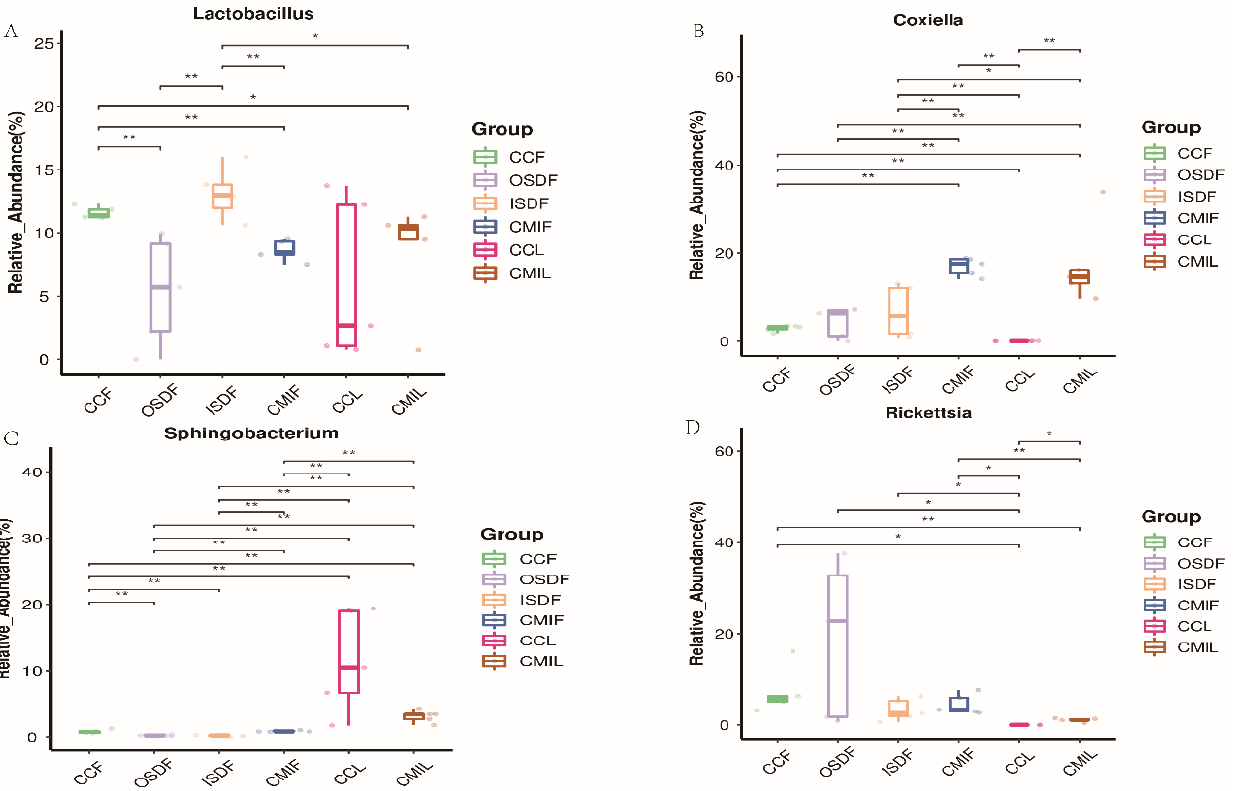
Figure 7. Relative titers of bacterial 16SrRNA gene from Lactobacillus ( A ), Coxiella ( B ), Sphingobacterium ( C ) and Rickettsia ( D ) between groups of H. flava and H. longicornis samples (* p < 0.05, ** p < 0.01). The groups of H. flava are CCF, OSDF, ISDF and CMIF and the groups of H. longicornis are CCL and CMIL.